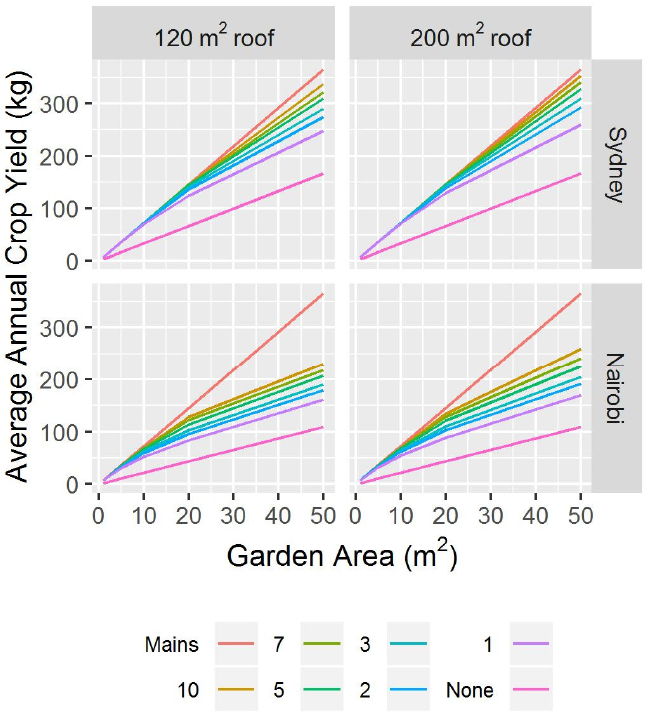
Figure 2. Average annual crop yield (kg) (1, 2, ..., 10 indicate size of RSS in m 3 ).